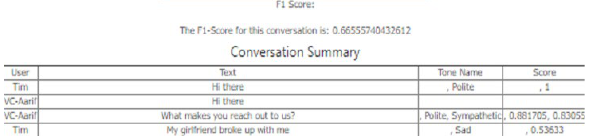
Figure 19. Displaying the Tone Analysis as well as the F1 -